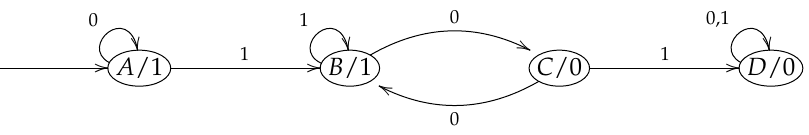
Figure 7. 2-DFAO generating the Baum–Sweet sequence. X/j means that the output associated with the state X is j